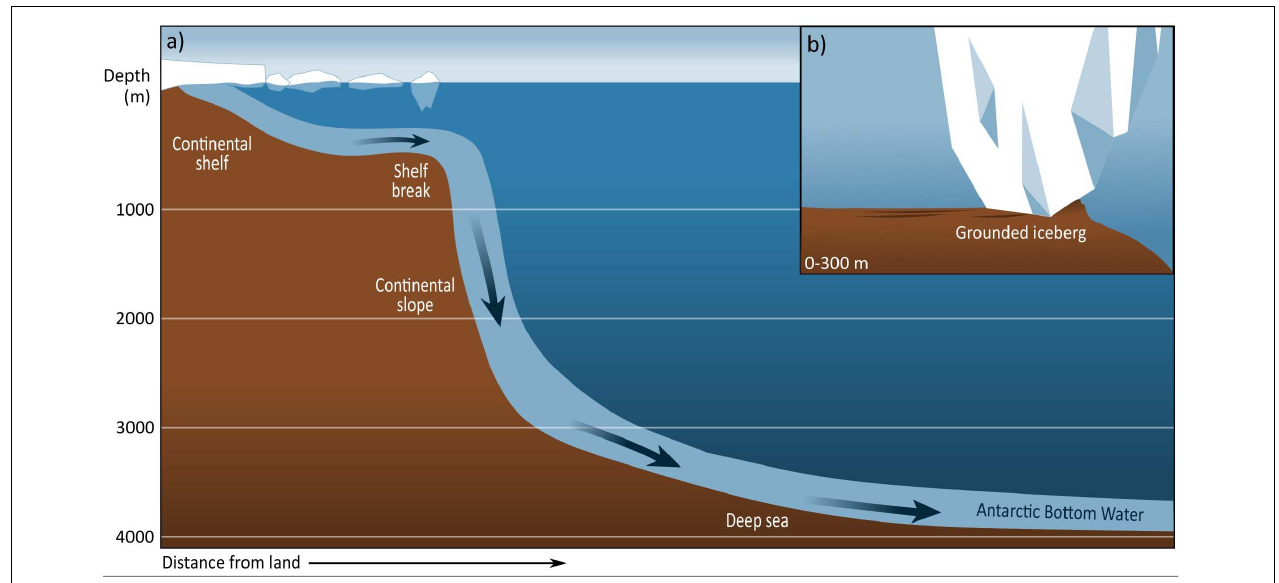
FIGURE 2 | (a) Depth profile of Southern Ocean seafloor and (b) grounded iceberg on the Antarctic shelf, grounding like this is most common between 0 and 300